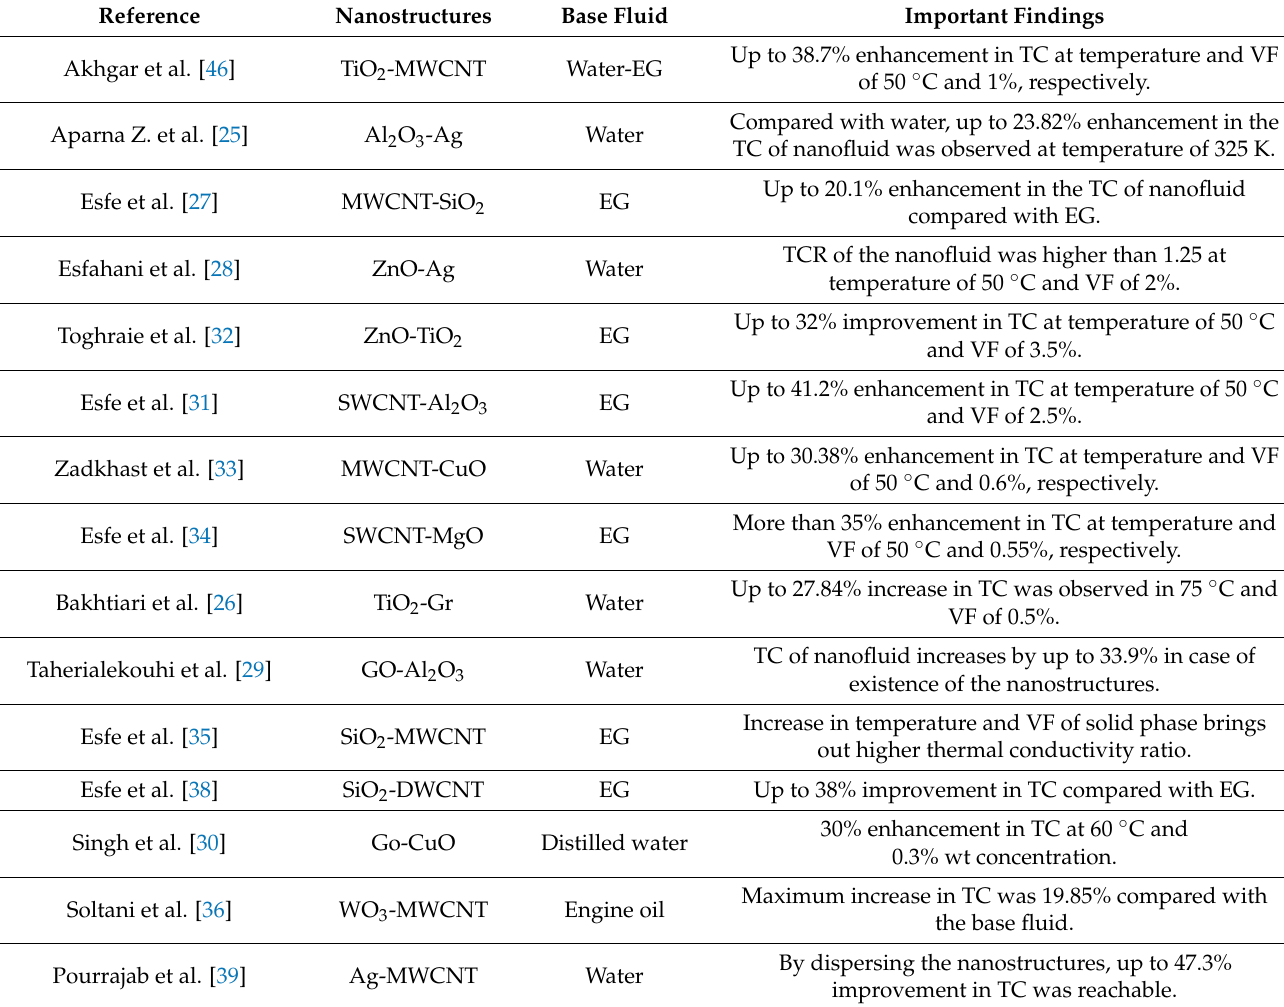
Figure 5. TCR of SiO 2 − TiO 2 /water-EG for different temperatures and VFs and T = 80 °C. Adapted from Ref. [50]. Table 1. Findings of the works on the TC of hybrid